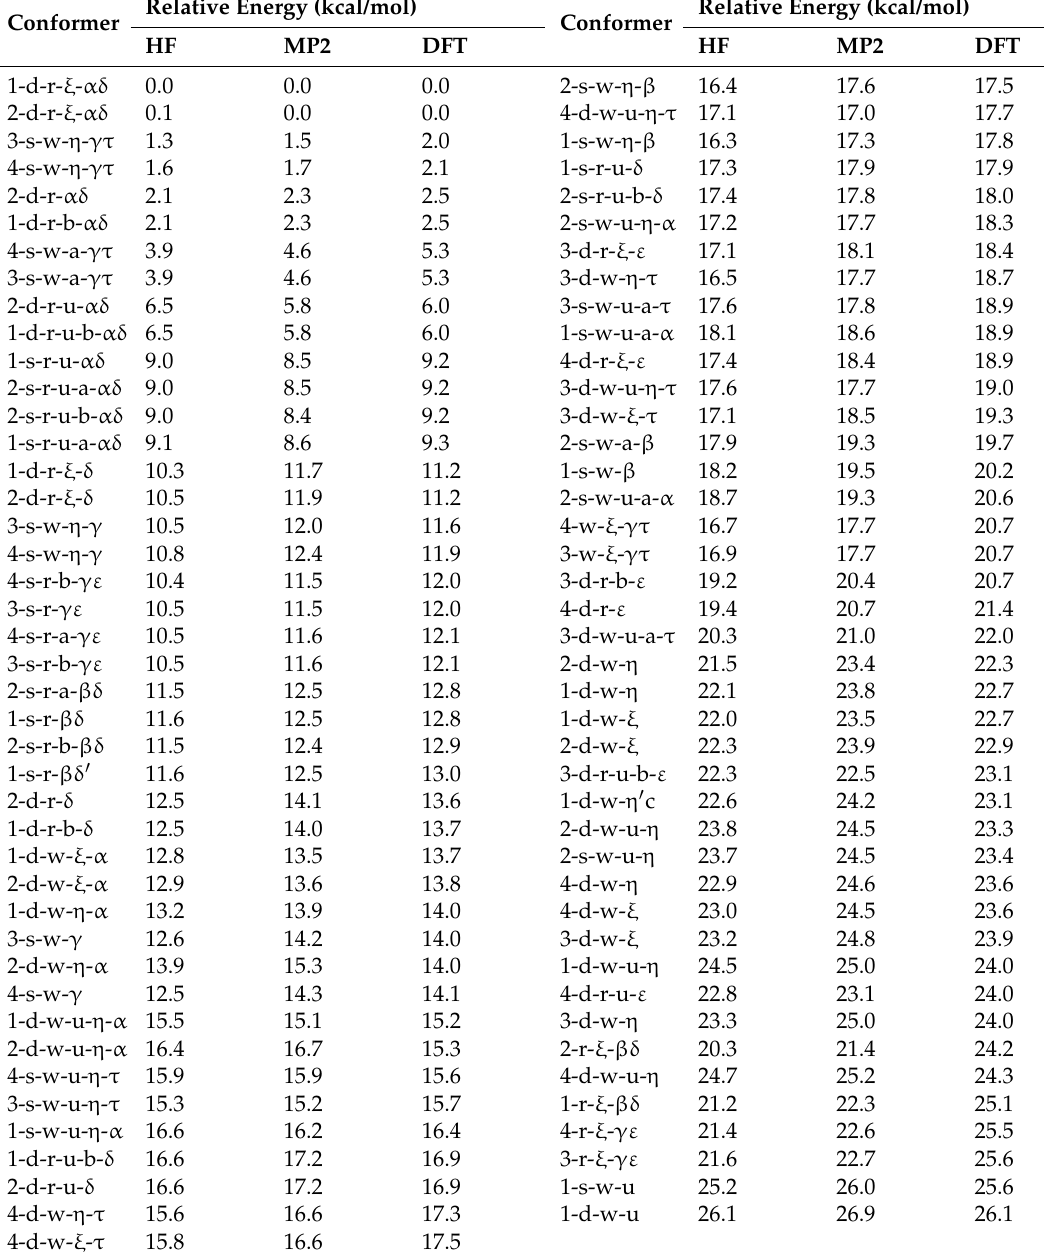
Table 2. Relative energies of the calculated conformers of arzanol from the results of different calculation methods in vacuo. The calculation methods are denoted with the following acronyms: HF for HF/6-31G(d,p), MP2 for MP2/6-31G(d,p)/HF/6-31G(d,p) and DFT for DFT/B3LYP/6-31+G(d,p). The table lists all the conformers that optimise to geometries with the same IHB patterns with both HF and DFT. The conformers are listed in order of increasing energy referred to the DFT